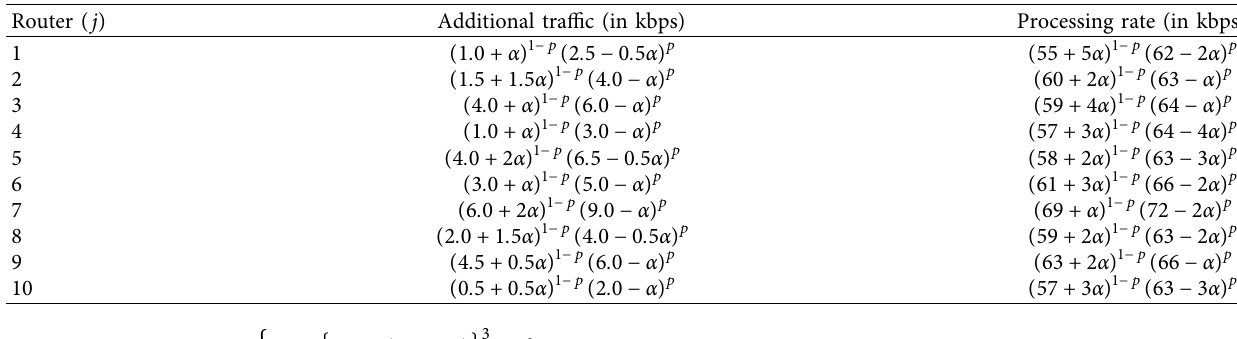
Table 2: Additional traffic and processing rate of each server in terms of α -level interval. Router ( j )